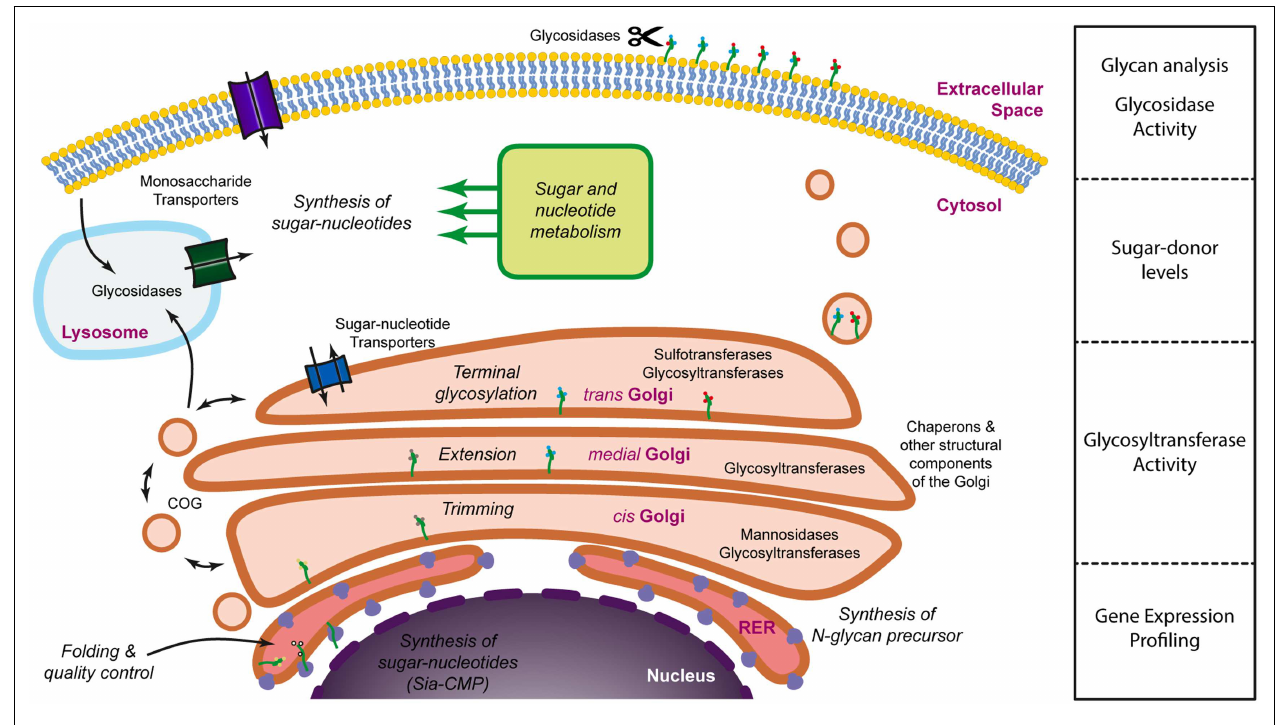
carbohydrates. Since many of these molecules are subjected to regulation, glycosylation is a highly dynamic process and it is, therefore, interesting to address not only the array of glycans present on the cell surface or the secretome, but also the activity and the expression levels of the molecules involved in glycan